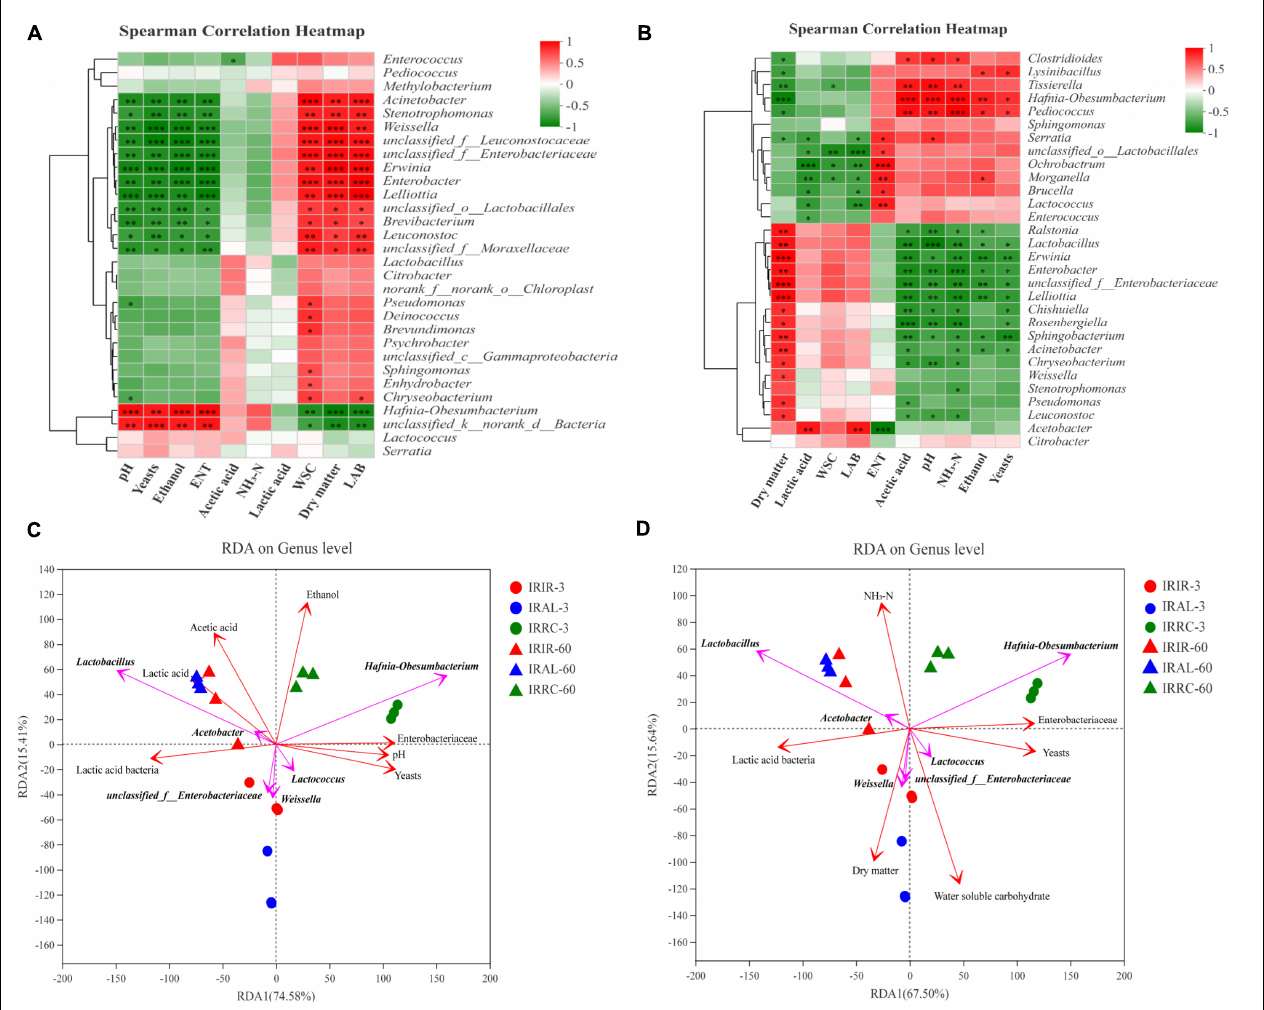
FIGURE 3 | Spearman’s correlation heatmap in Italian ryegrass silages on day 3 (A) and 60 (B) , respectively. (C,D) Redundancy analysis (RDA) on genus level in Italian ryegrass silages. IRIR, sterile Italian ryegrass inoculated by epiphytic bacteria from Italian ryegrass; IRAL, sterile Italian ryegrass inoculated by epiphytic bacteria from alfalfa; IRRC, sterile Italian ryegrass inoculated by epiphytic bacteria from red clover; 3, 3 days of ensiling; 60, 60 days of ensiling. ∗ , 0.01 < p < 0.05; ∗∗ , 0.001 < p < 0.01; ∗∗∗ , p <